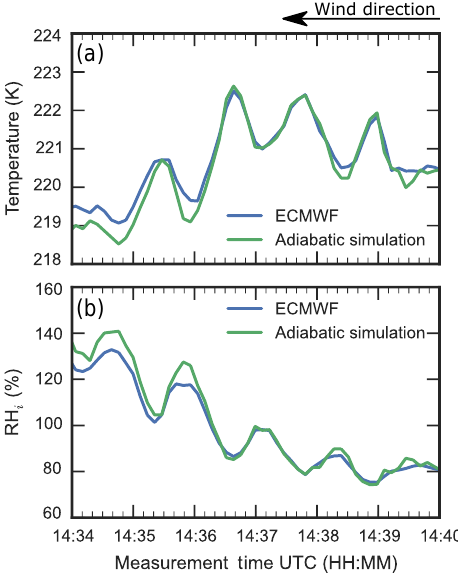
Figure 7. Simulation of temperature T and relative humidity RH i . Green lines are simulated values along a derived trajectory (Fig. 5) assuming adiabatic cooling and heating within the gravity wave, re- spectively. In blue are ECMWF values interpolated to the trajectory